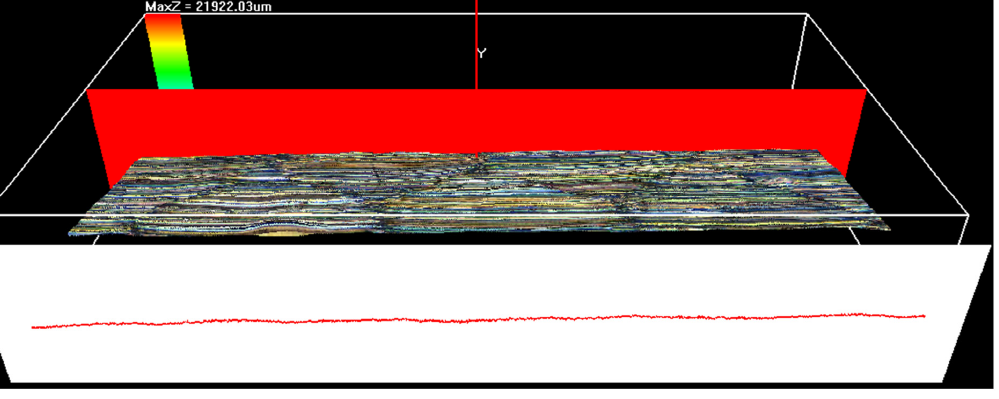
Figure 28. Workpiece surface topography machined by BEM with inclination angle of approxi- mately 20°.